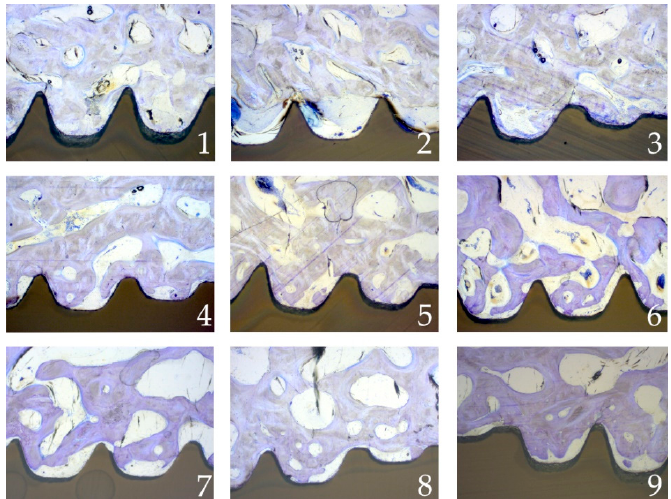
Figure 10. BIC values in percent ± standard deviation after 2, 4, and 9 weeks of healing. Table 1. BIC values after 2, 4, and 9 weeks of healing. Healing Period